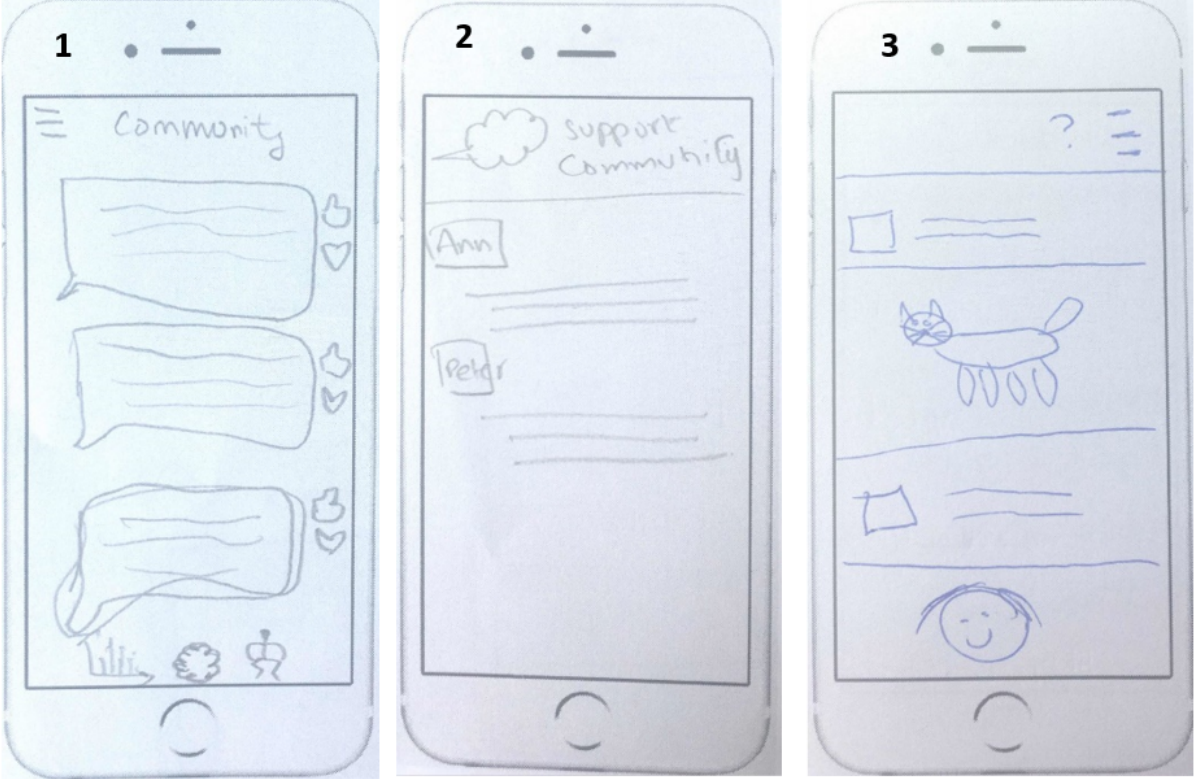
Figure 7. Three implementation ideas of a social support feature were generated by participants: (1) ability to reply to a comment, (2) ability to chat privately, and (3) ability to upload pictures in the chat